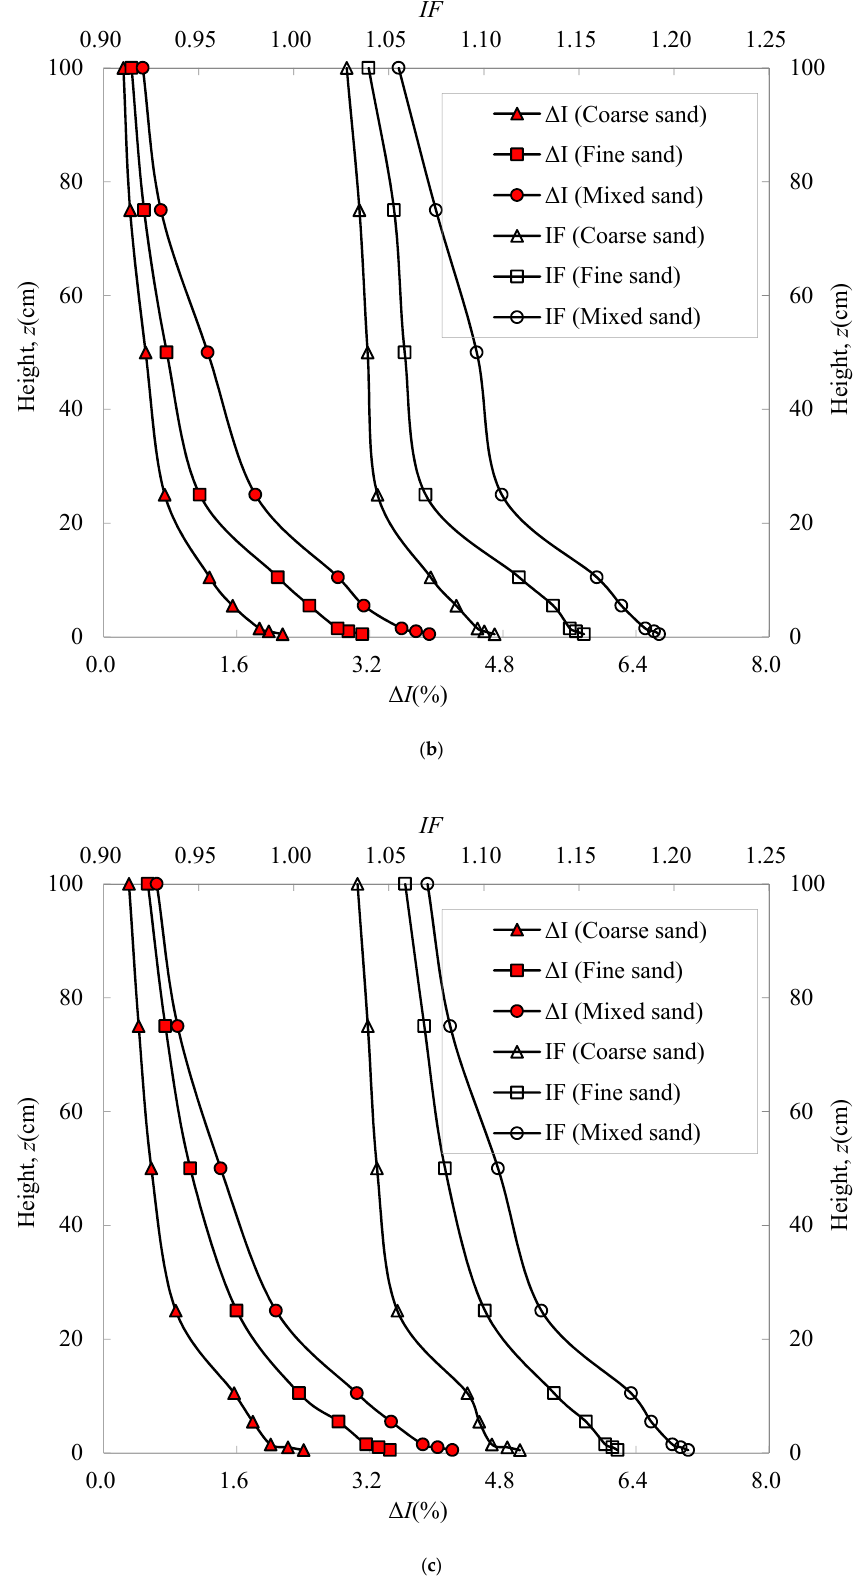
Figure 13. The influence of particle movement on the turbulence intensity: ( a ) At the indicated wind speed of 14.74 m/s; ( b ) At the indicated wind speed of 16.68 m/s; ( c ) At the indicated wind speed of 18.61